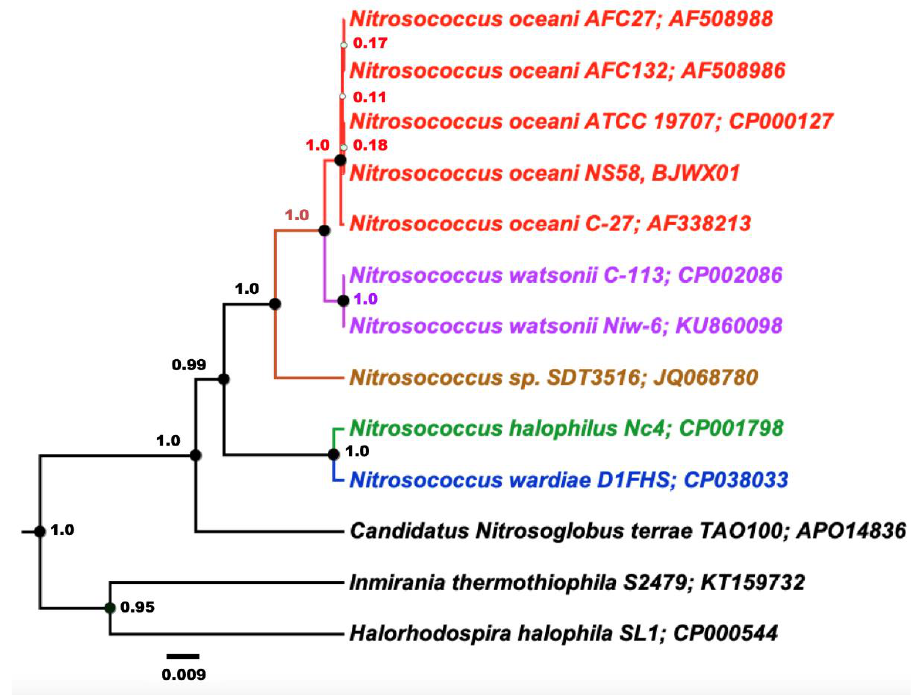
Figure 3. Inferred phylogenetic relationships among the five investigated strains of Nitrosococcus oceani based on one of their two identical 16S rRNA gene sequences in the context of Chromatiales bacteria. The phylogenetic tree was constructed based on an alignment of 16S rRNA gene sequences subjected to Bayesian inference employing a Gamma + Invariant sites heterogeneity model with four gamma categories with a strict clock model. Node values are Bayesian posterior probabilities based on 10,000,000 iterations, minus a burn-in of 20% of total. The scale bar represents 0.009 changes per nucleotide position. Colors indicate established taxonomic